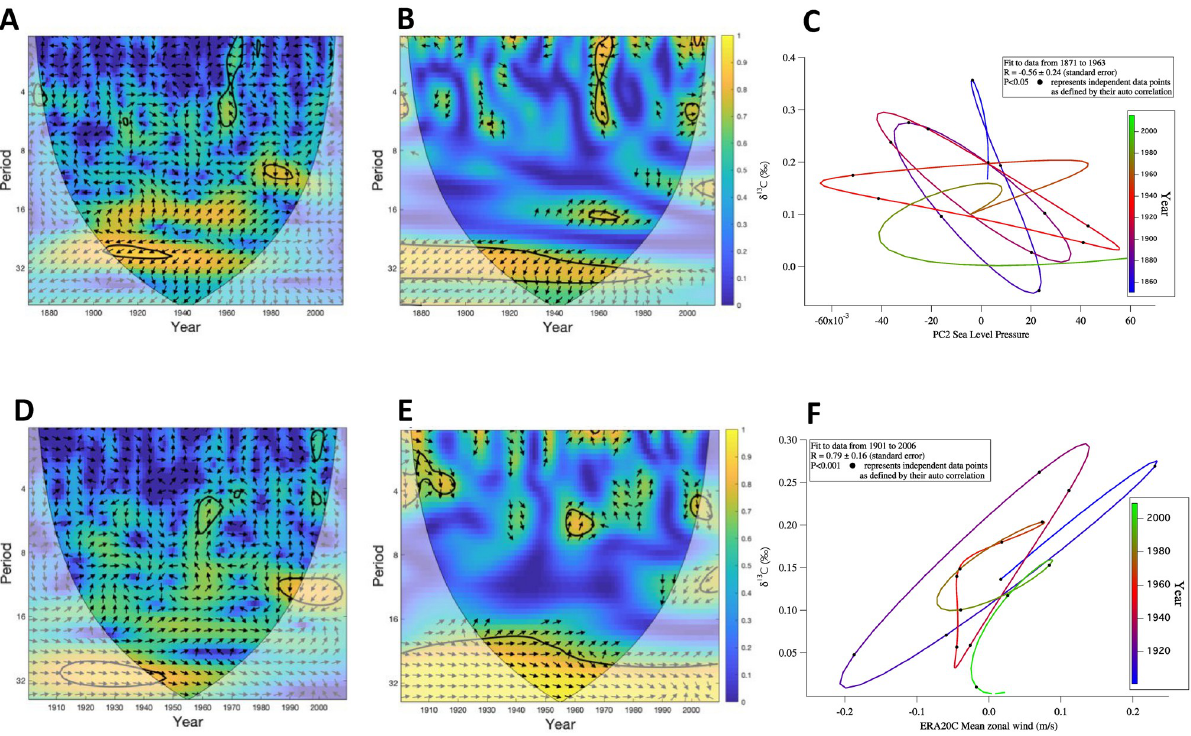
Fig 6. Comparison of stable carbon isotope time series with East Atlantic Pattern (EAP) and local wind forcing on the NIS. (A) Cross Wavelet Transform (XWT) analysis between δ 13 C time series of N . pachyderma and PC2 SLP 20CR over the North Atlantic domain: 2nd principal component from 20th Century sea-level pressure data [84], (i.e. the EAP), (B) Wavelet coherence analysis (WTC) between the two time series. The thick black contour designates the 5% significance level against red noise and the cone of influence where edge effects might distort the picture is shown as a lighter shade; the relative phase relationship is shown as arrows (with anti-phase pointing left), (C) Crossplot between the lowpass filtered N . pachyderma δ 13 C and PC2 SLP time series displaying the anticorrelation between the data; using the Stats Linear Correlation Test from IGOR PRO 6 software. The timeline displays that their antiphase relationship disappears from the 1950s onwards when the Marine Suess effect dominates. (D) Cross Wavelet Transform (XWT) analysis and (E) WTC between δ 13 C time series of N . pachyderma the surface easterly wind component (Vwind) of ERA-20C data of the 20th century from 1900–2010 [87] for winter months (NDJ) from a narrow 3 by 3-degree grid box (65–68 ˚N, 19–22 ˚W) North of Iceland over the core location; the relative phase relationship is shown as arrows (with in-phase pointing right), (F) Crossplot between the bandpass filters of N . pachyderma δ 13 C and the surface easterly wind component (Vwind) of ERA-20C data of the 20th